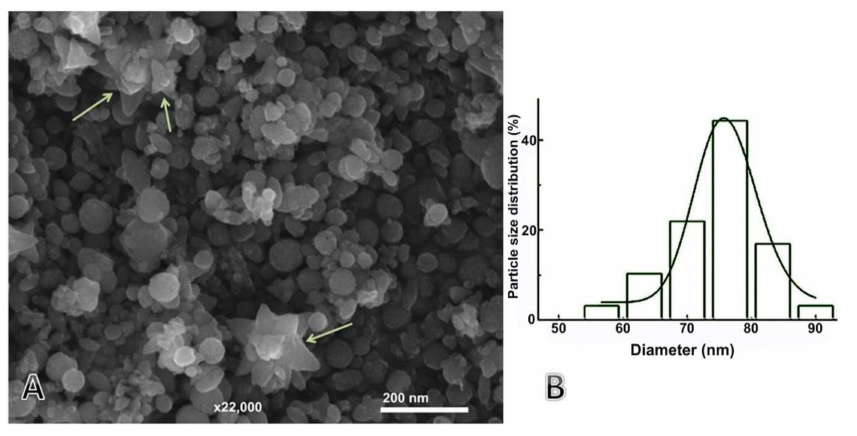
Figure 5. SEM micrographs ( A ) and size distribution ( B ) of phycosynthesized ZnONPs .